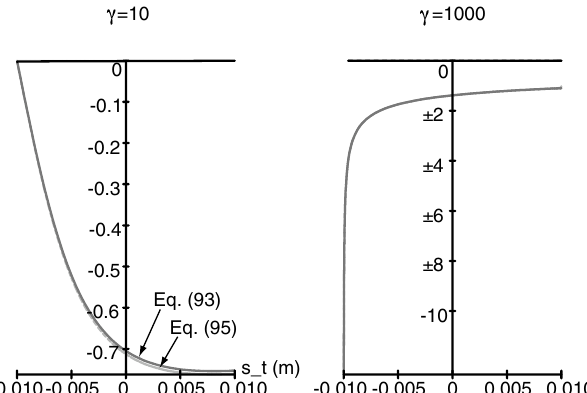
(cid:2) s ; 0 ; 0 (cid:3) , for R (cid:1) 10 m , L (cid:1) 0 : 01 m , for FIG. 11. Plot of G s t two (cid:23) values. In both cases the result from this paper, Eq. (83), (cid:3) = (cid:2) 4 (cid:12)(cid:13) (cid:3) is suppressed is plotted as a solid line. The factor (cid:2) e(cid:9) 0 0 in this and the next plot. For (cid:23) (cid:1) 10 the exact Saldin formula (87) is plotted as a broken line. For (cid:23) (cid:1) 1000 the high-energy approximate formula (88), G (cid:2) (cid:23) (cid:19) 1 =u s (cid:3) s , is plotted as a broken line. Especially for the (cid:23) (cid:1) 1000 graph, the curves superimpose well enough to be scarcely